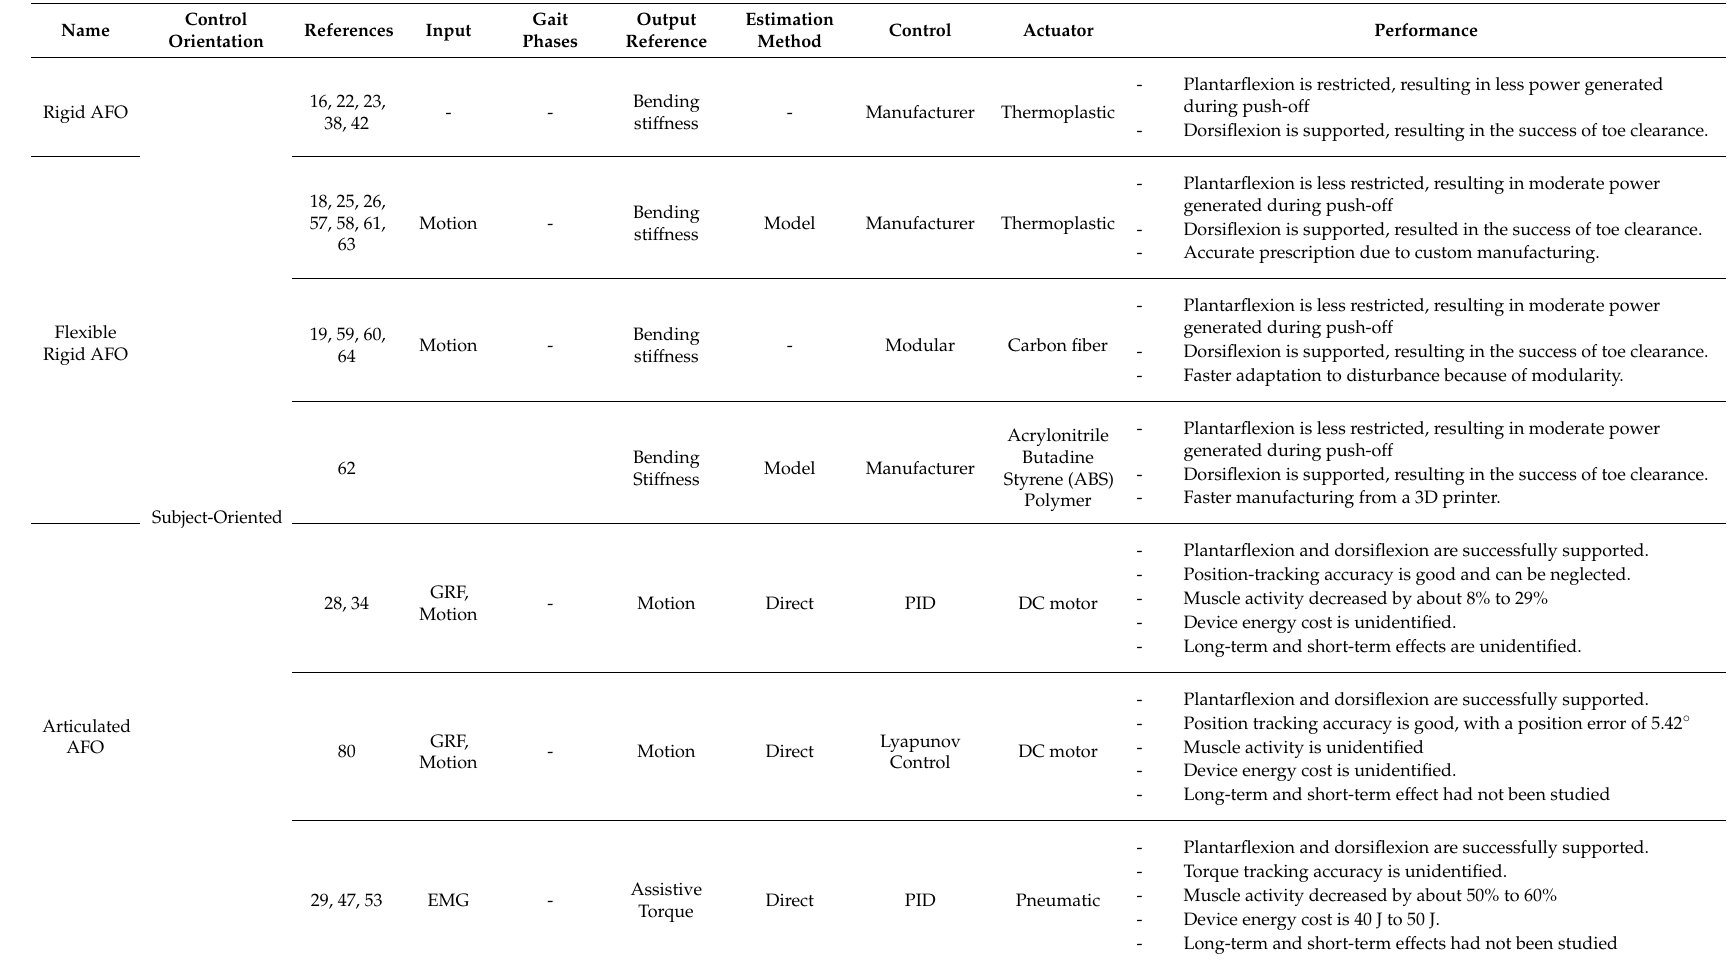
Table 1. The comparison of the development of AFO over the past